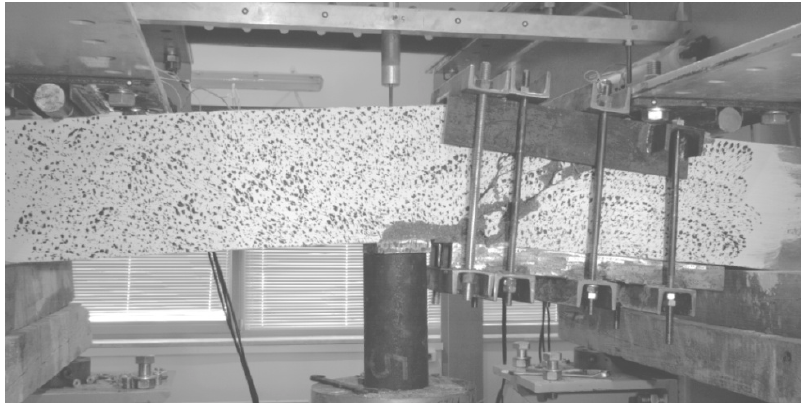
Figure 17. Example of a shear tension failure in the shear area of BF series beams.